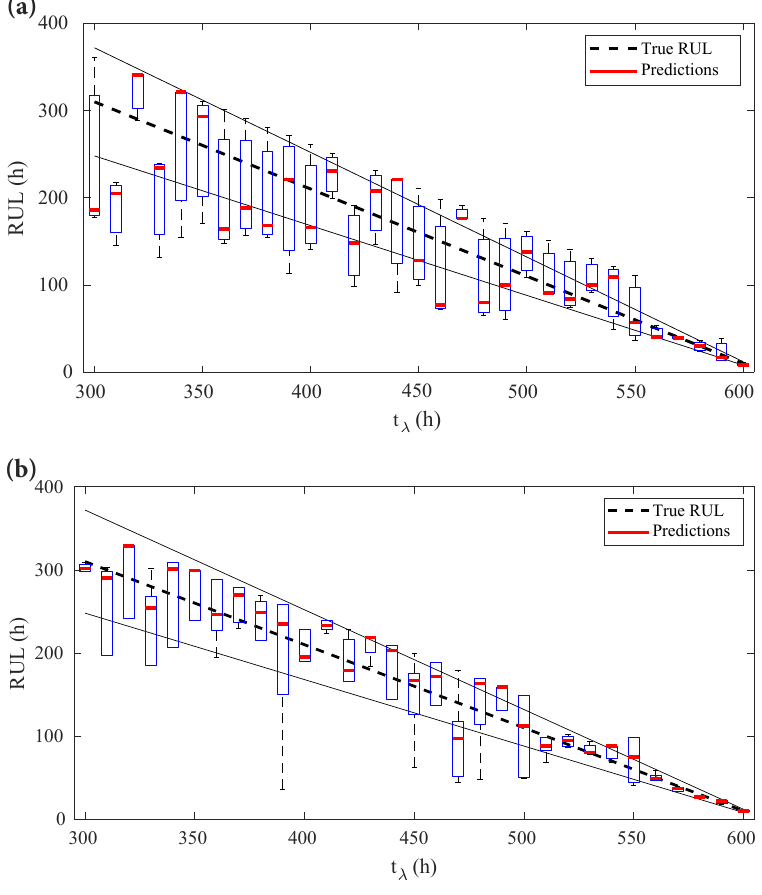
Figure 8. RUL prediction results from 300 to 600 h: ( a ) Output voltage observation-based RUL prediction results; ( b ) Degradation model-based RUL prediction